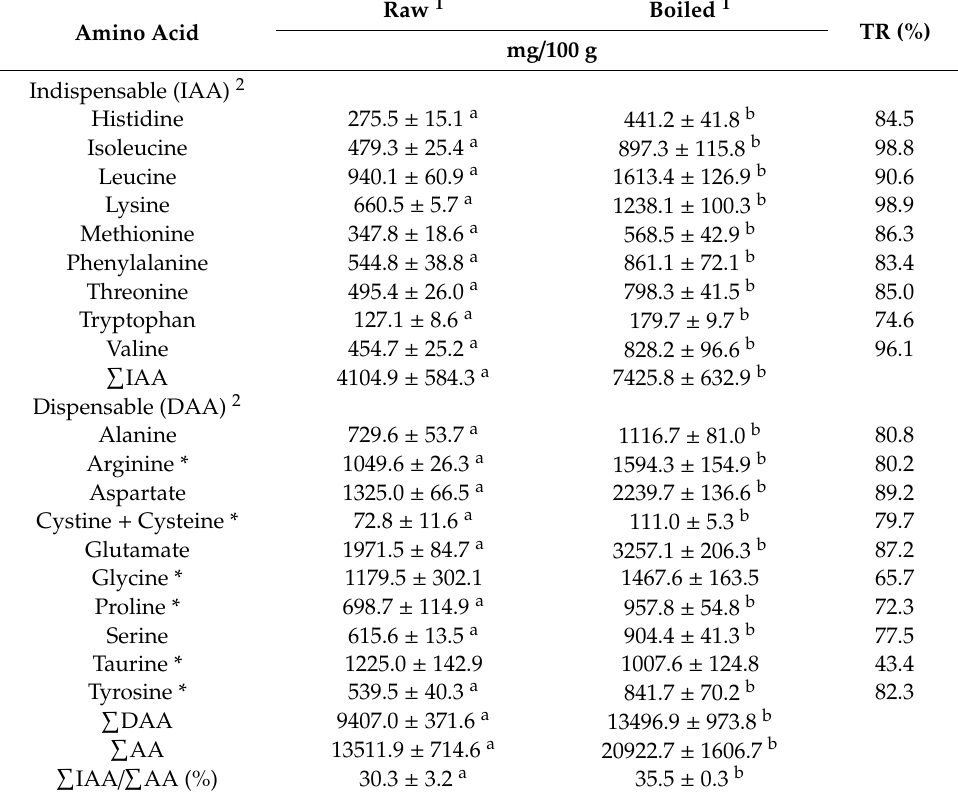
Table 5. Amino acids profile and true retention (TR) of common